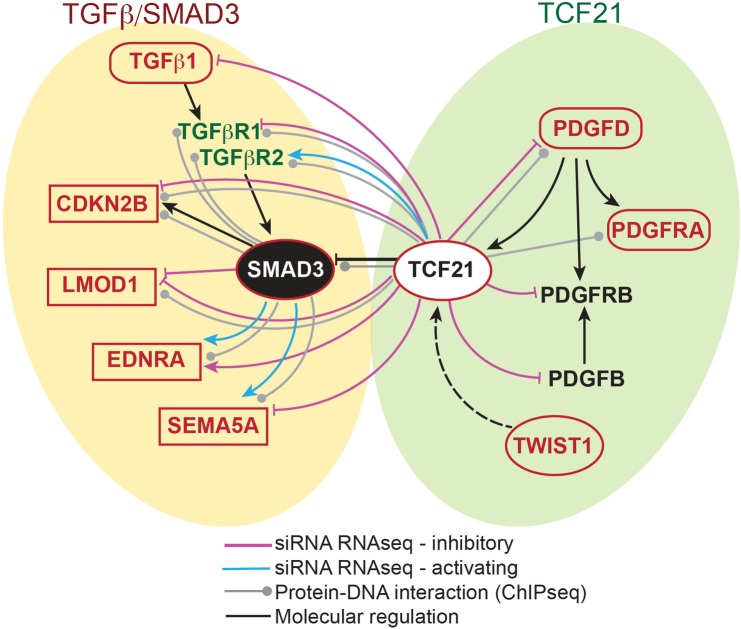
Network of CAD associated genes that may regulate HCASMC phenotype as a mechanism of disease risk.Genes in red text reside in replicated CAD associated loci, with genomic and/or functional data supporting their causality [73, 75] [6, 7, 11, 21, 32–34, 56]. Gene symbols in ellipses indicate CAD associated transcription factors. HCASMC ChIPseq data presented here or previously published provide evidence of direct transcriptional regulation and RNAseq data provides evidence of directionality [34, 56]. These and other data reveal a pervasive role of the TGFβ pathway in CAD causality [10], and also suggest that linked TCF21 and PDGF signaling is an important component of disease risk.